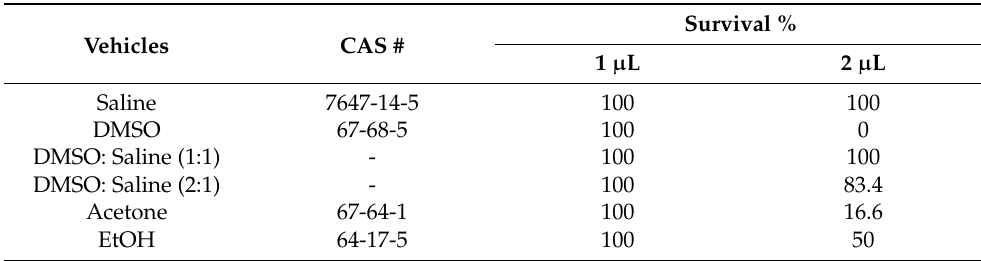
Table 1. Vehicles analyzed for toxicity studies in adult exemplars of T. molitor Coleoptera and survival percentage.